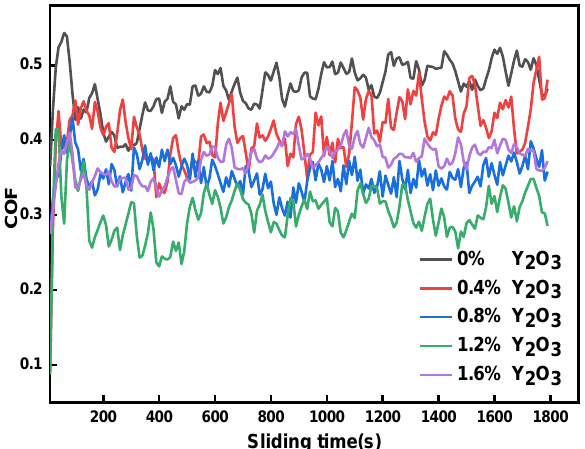
Figure 12. Friction coefficient curve of the modified surfacing layer with different contents of Y 2 O 3.